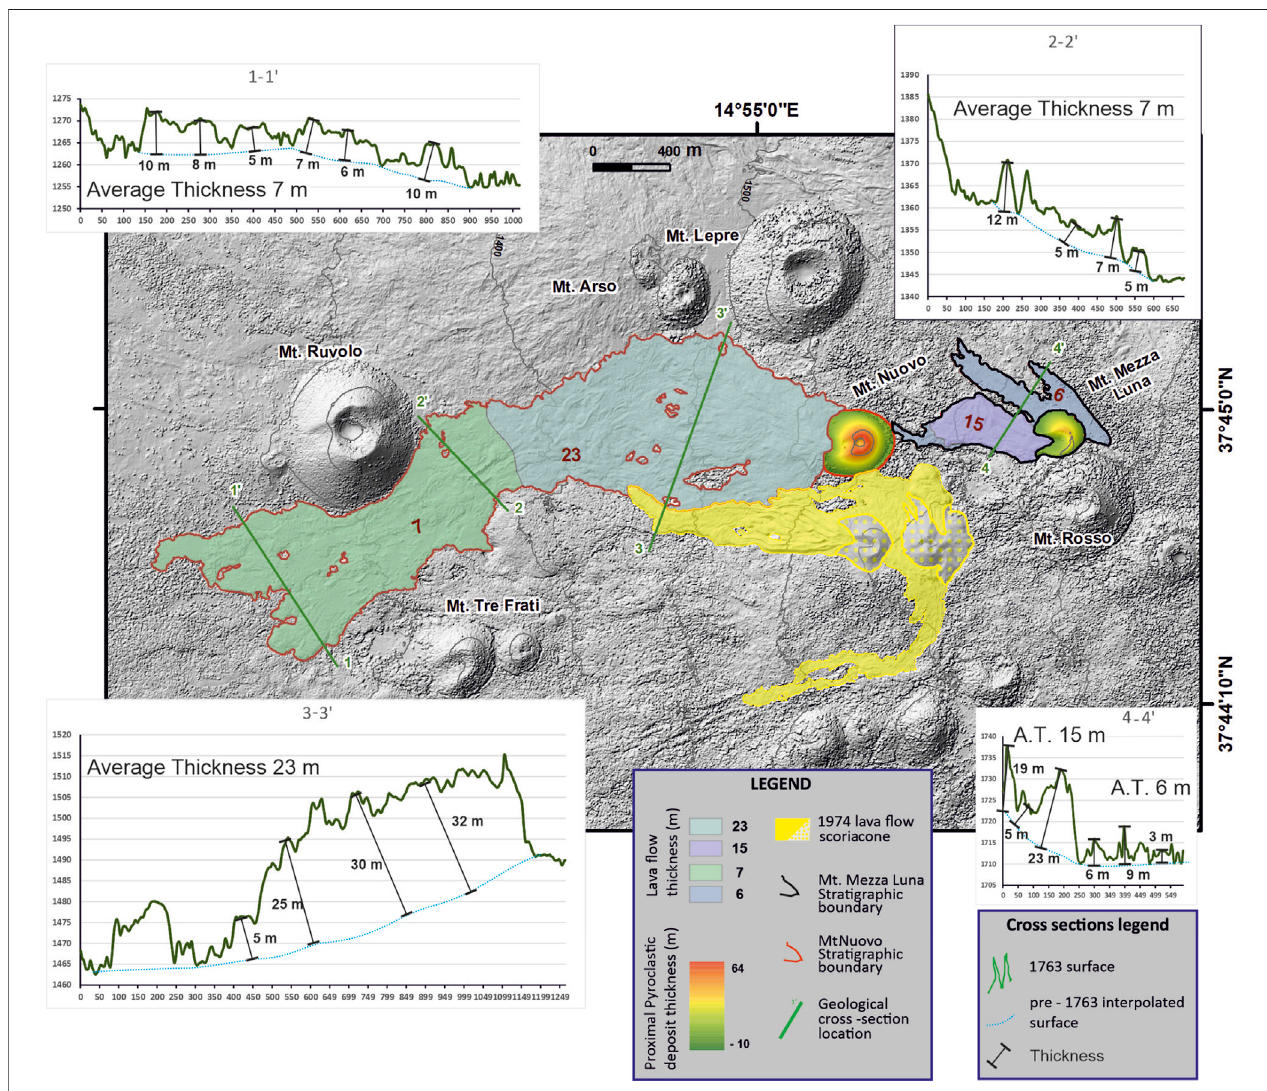
FIGURE 2 | Geological map of Mt. Nuovo and Mt. Mezza Luna. Four sectors of homogenous thickness evaluated interpolating the basal surface are shown in different colours (see the text for details). The green line indicates the location of the geological cross sections. Mts. De Fiore (1974 eruption) lava fl ows fi eld is plotted for comparison. A.T. (cid:2) Average thickness. In Section 4 – 4 ’ there are two different values of average thickness due to the major difference between the two lava fl ows branches in term of thickness.